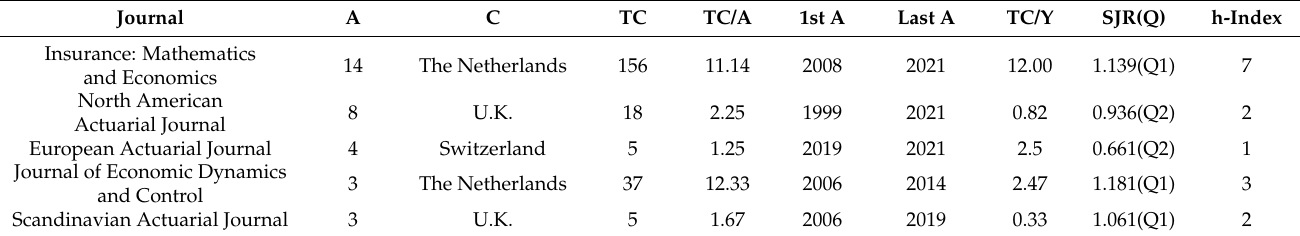
Figure 10. Evolution over time of published articles and total citations on pension research in the Mathematics area. Source: own elaboration. Table 12. The top 5 most productive journals on pension research in the area of